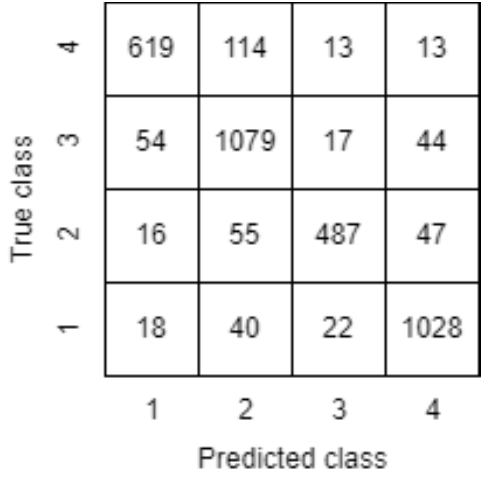
Figure 5. Confusion matrix for the test